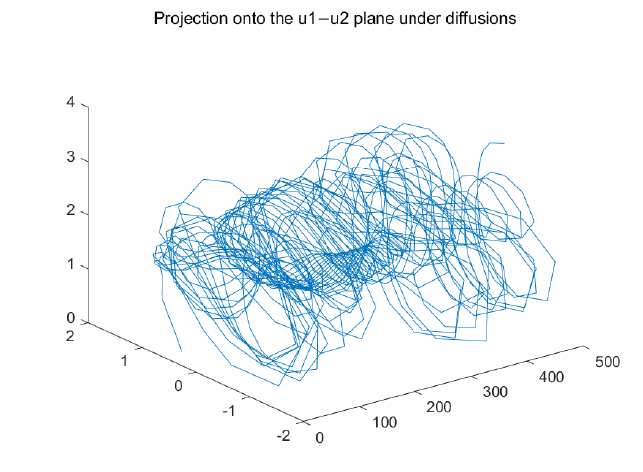
Figure 4. Computer simulations of chaos of financial system under diffusions.